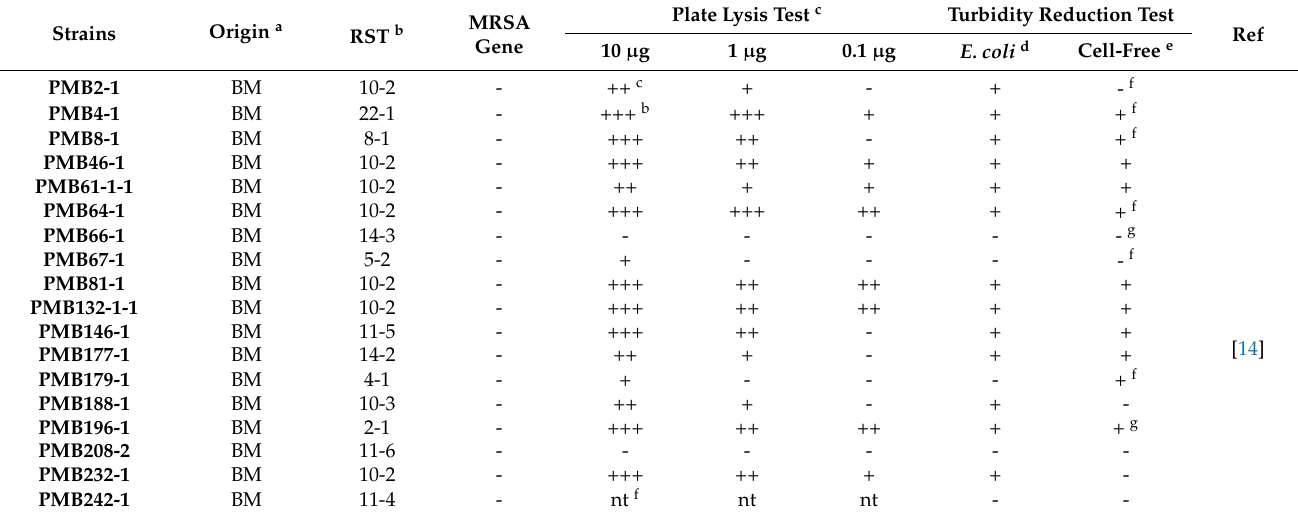
Table 1. S. aureus strains used in the study and their susceptibility to